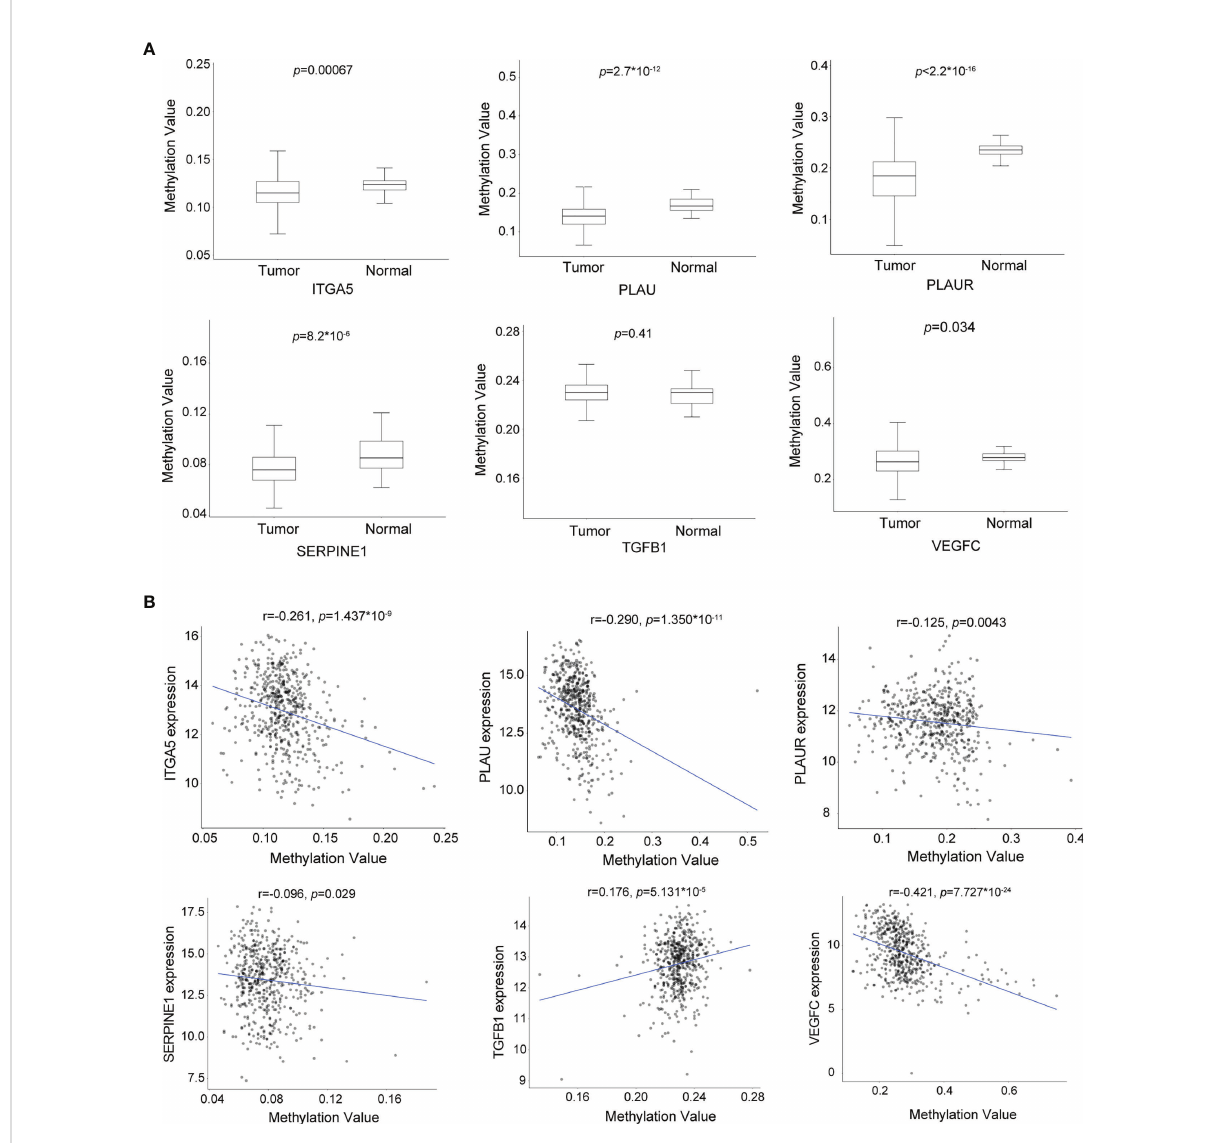
FIGURE 6 The expression levels of the biomarker candidates are regulated by DNA methylation in head and neck squamous cell carcinoma (HNSCC). (A) DNA methylation levels of ITGA5 , PLAU , PLAUR , SERPINE1 , TGFB1 , and VEGFC in HNSCC ( n = 530) and normal ( n = 50) tissues. (B) Correlation between the DNA methylation levels and gene expression levels of ITGA5 , PLAU , PLAUR , SERPINE1 , TGFB1 , and VEGFC ( n = 502 and n = 22 for HNSCC and normal tissues, respectively). * means